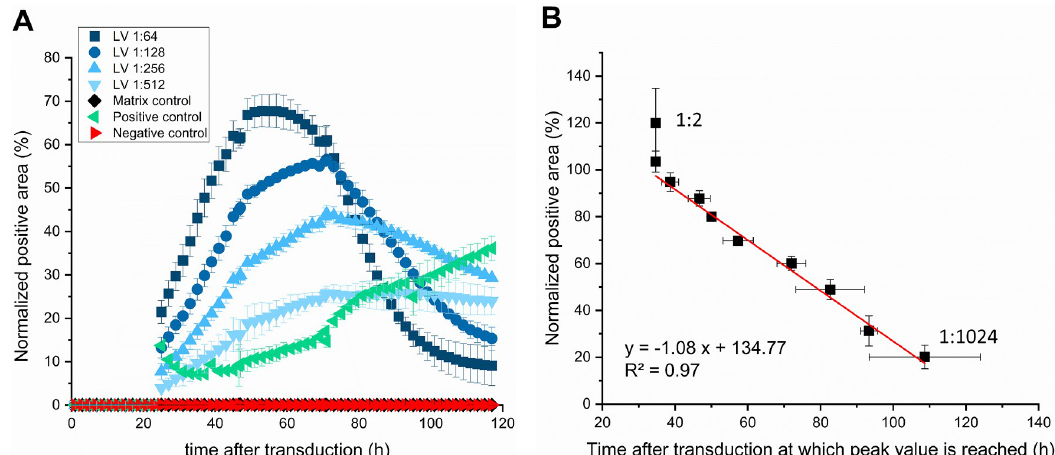
Fig 4. Time course series of normalized positive cell area. (A) The FabFluor-488 positive area was normalized to the phase contrast area over time after transduction. The IgG1 isotype negative control and the lentiviral vector (LV) negative control (matrix) showed no FabFluor488 signal. The anti-transferrin-receptor IgG1 positive control antibody confirmed successful FabFluor488 labeling of the test antibodies. Matrix control overlaps with the negative control. Data represent the mean ± standard deviation of three technical replicates. (B) Normalized FabFluor488 peak value vs. time at which this value is reached. The datapoint in the upper left with the highest normalized positive area represents the 1:2 LV dilution. The other datapoints represent two-fold serially diluted LV up to a dilution of 1:1024 with the lowest normalized positive area and the longest time after which the peak value is reached. Data represent the mean ± standard deviation of three biological replicates.